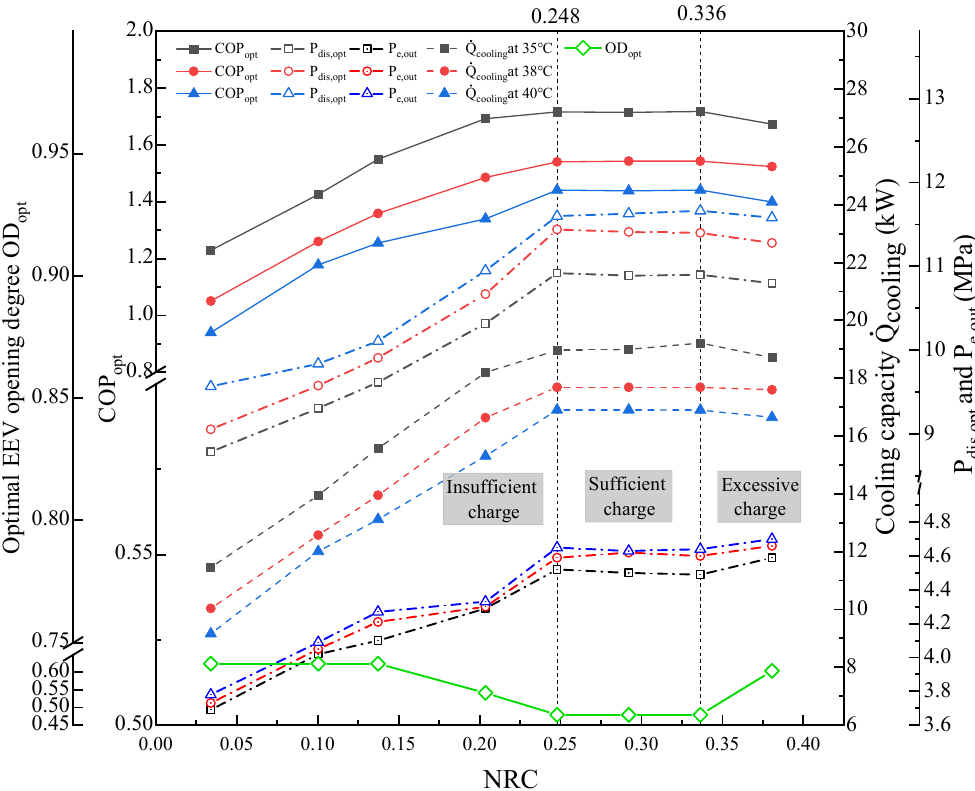
. Q cooling ), optimal discharge